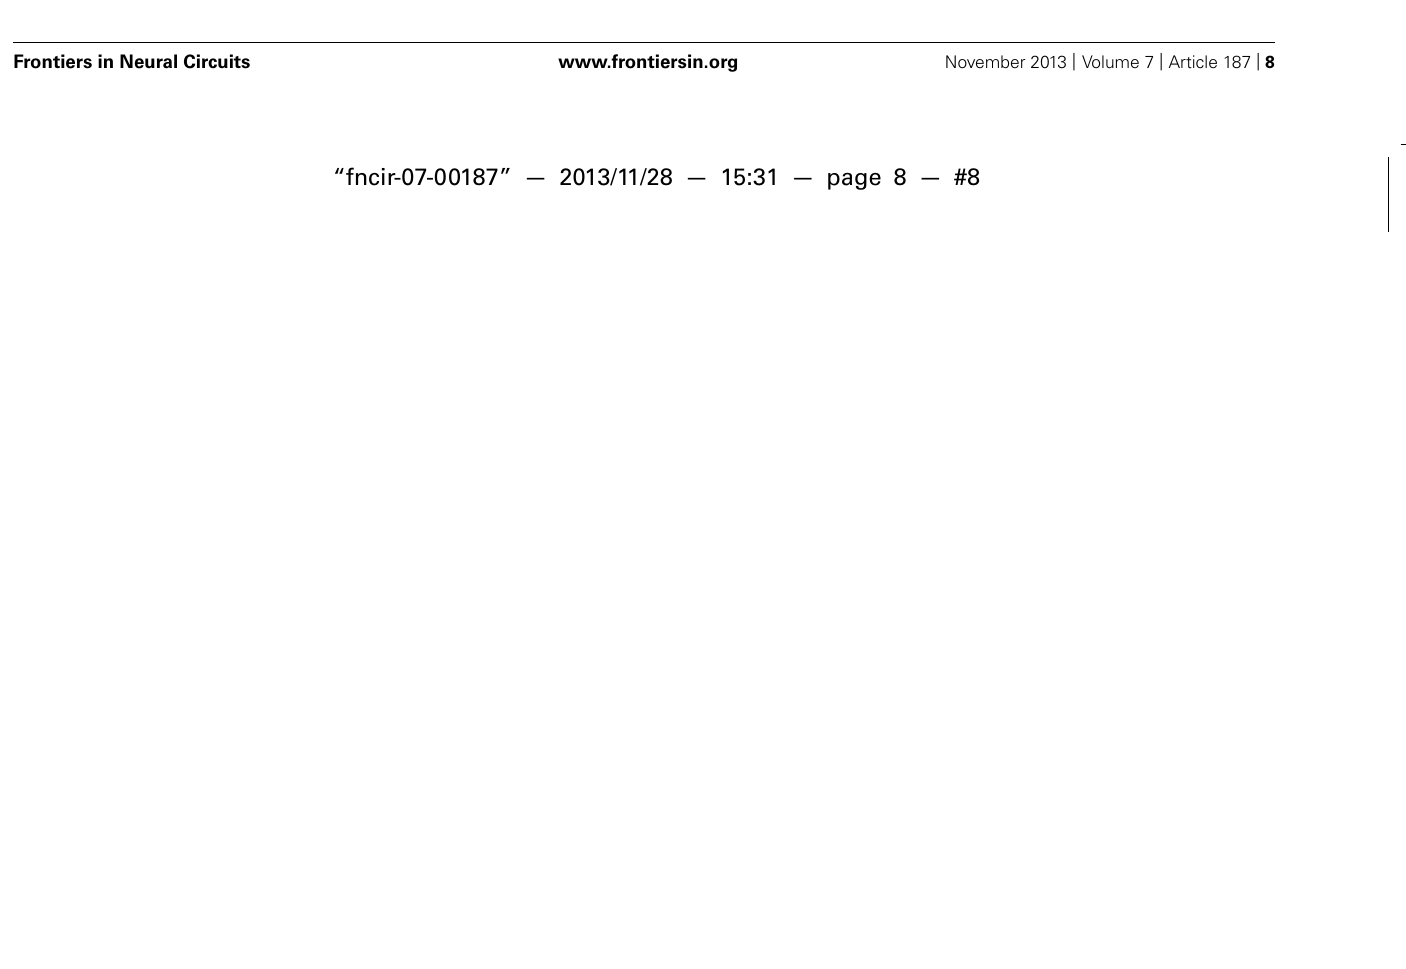
PI3-kinase, phosphoinositide-dependent kinase, and